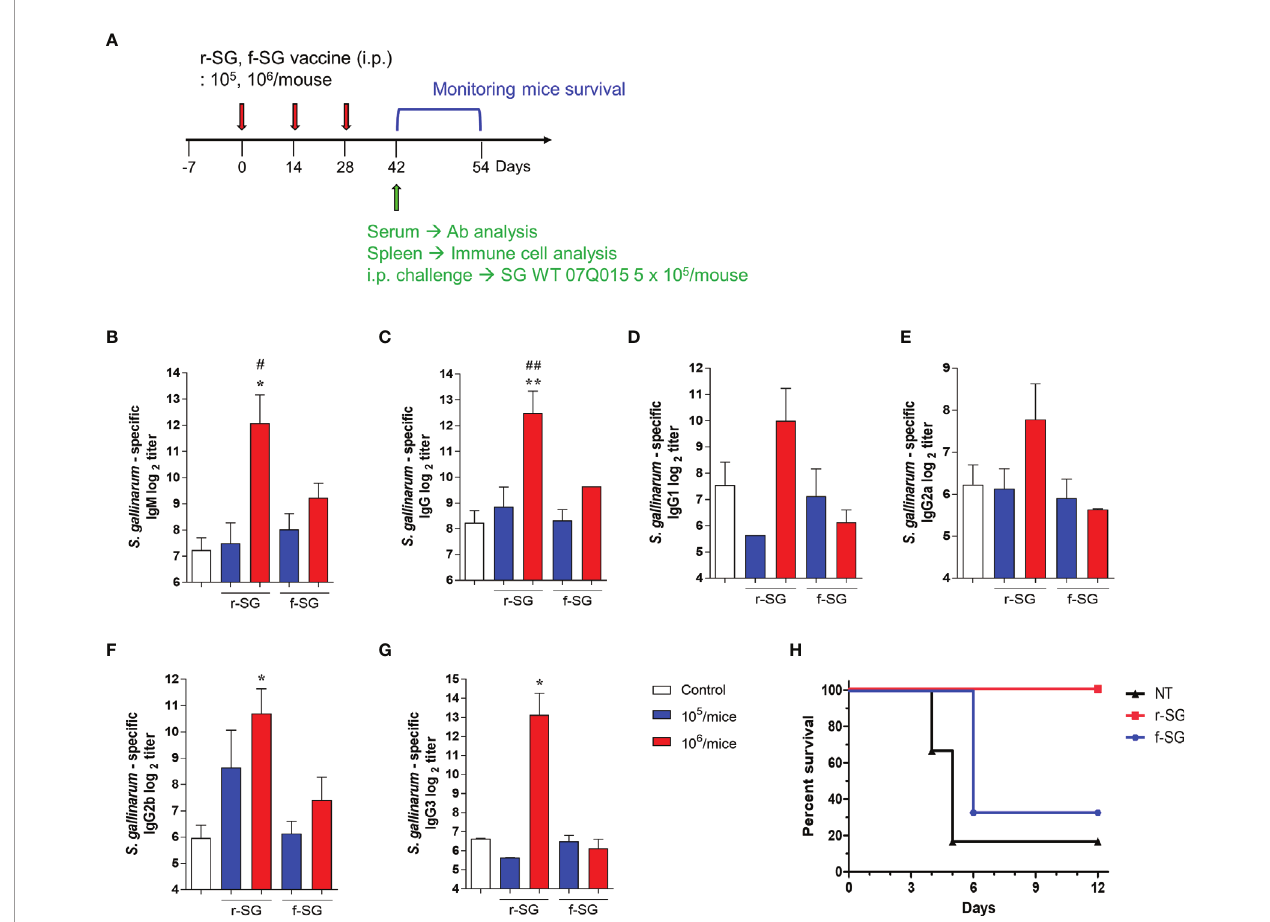
FIGURE 2 | Analysis of humoral immune responses induced by immunization of r-SG or f-SG. Mice (n = 5 per group) were immunized i.p. with either 1 × 10 5 CFU or 1 × 10 6 CFU of r-SG or f-SG three times at two week intervals and sera were collected two weeks after the last vaccination. (A) Schematic overview of mice study design. SG-speci fi c (B) IgM and (C) IgG and IgG subclasses (D) IgG1, (E) IgG2a, (F) IgG2b, and (G) IgG3 in sera were measured by ELISA. (H) Immunized mice (n = 6 per group) were infected i.p. with 5 × 10 5 CFU SG WT strain and survival was monitored for 12 d. *P < 0.05, **P < 0.01 compared to PBS